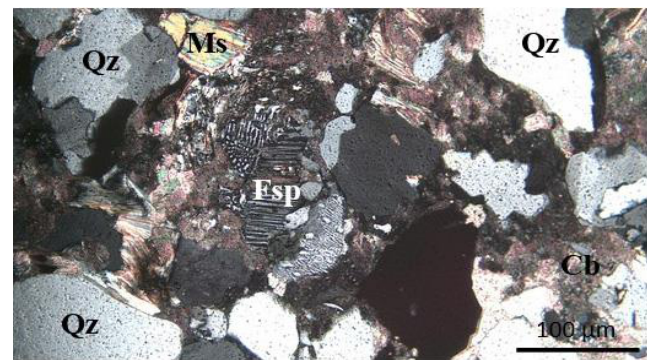
Figure 10. Micropertites on feldspar grains (F sp ), surrounded by quartz (Q z ), muscovite (M s ), and carbonate binder (C b ): crossed polars—100× magnification.